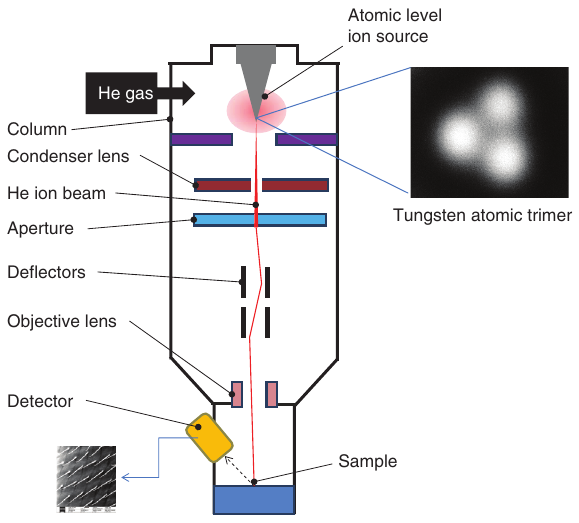
Figure 1 Schematic of a helium ion